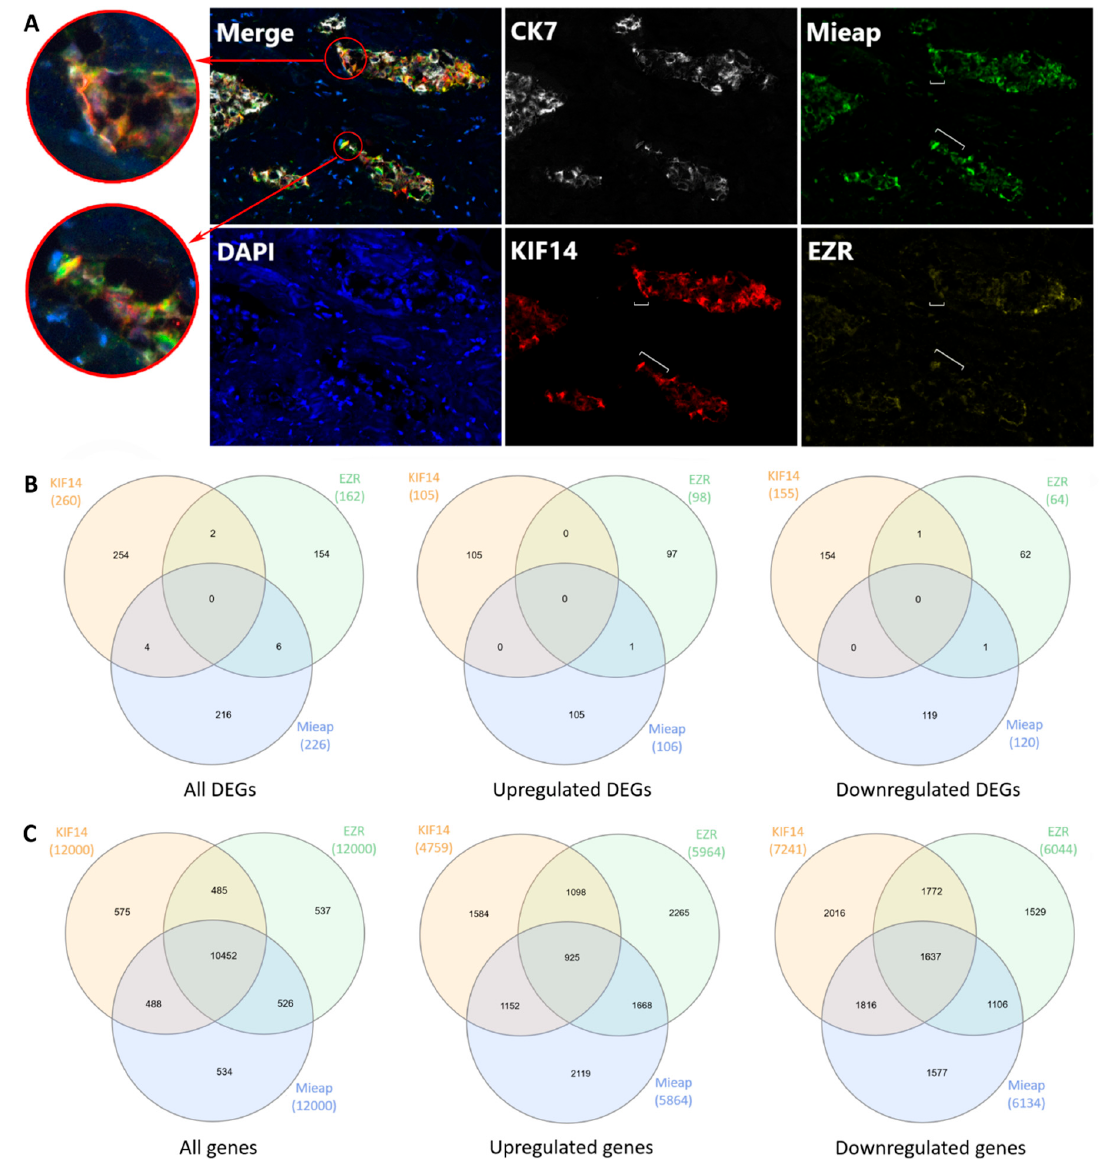
Figure 6. Localization of KIF14-positive, Mieap-positive, and EZR-negative cells in the torpedo-like structures. Expression of KIF14, Mieap, and EZR proteins in the torpedo-like structures. A white bracket indicates the tip of the torpedo-like structures ( A ). Venn diagram summarizing the shared DEGs among KIF14-positive, Mieap-positive, and EZR-negative cells ( p < 0.05) ( B ). Venn diagram summarizing all genes shared between KIF14-positive, Mieap-positive, and EZR-negative cells ( C ).